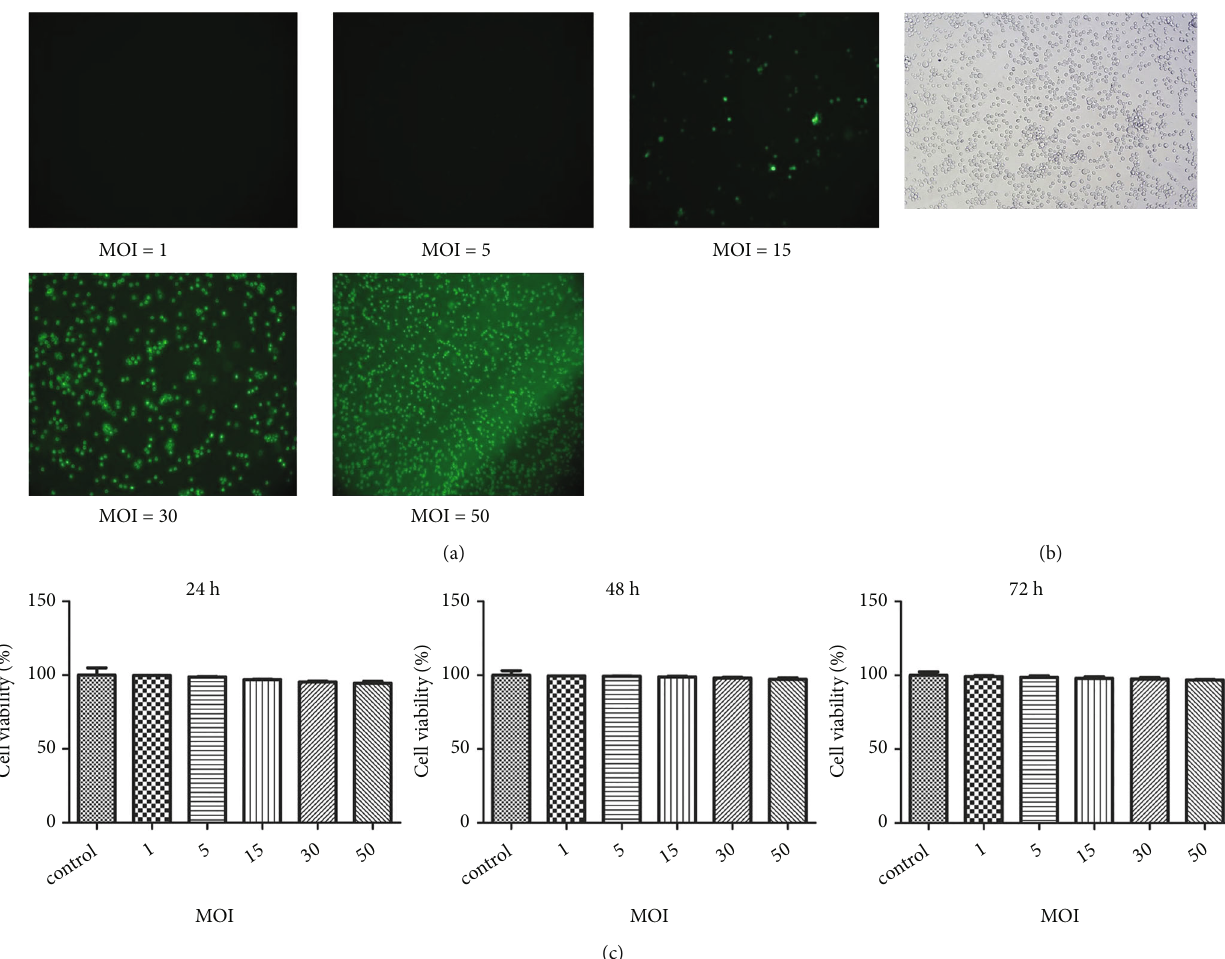
Figure 1: Lentivirus-mediated transfection e ffi ciency after 72 hours post-infection. (a) Fluorescence intensity in Raji cells after transfection with di ff erent MOI for 72 hours under a fl uorescence microscope. (b) The cellular morphology after transfection for 72 hours under a light microscope. (c) The cell viability of the cells transfected with di ff erent MOI of shRNA negative control (NC) after cultured for 24, 48, and 72 hours using cell counting